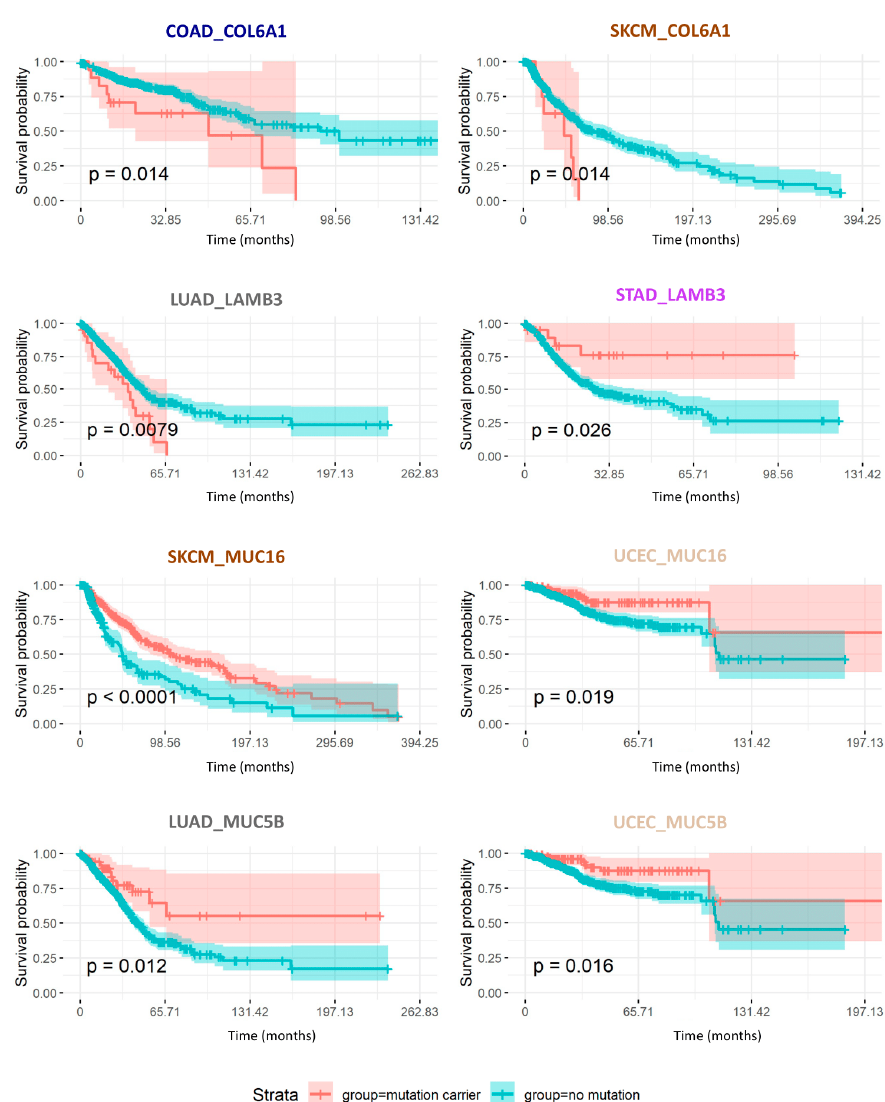
Figure 7. Mutation burden in core matrisome genes impact cancer patient overall survival. Kaplan–Meier curves represent the overall survival probability over time (in months) of patients carrying (coral trace) or not (teal trace) mutations in the specified core matrisome genes COL6A1 and LAMB3 , or matrisome-associated genes MUC5B or MUC16. P-values indicated correspond to the ones calculated in the univariate analysis. See Tables 3 and 4.